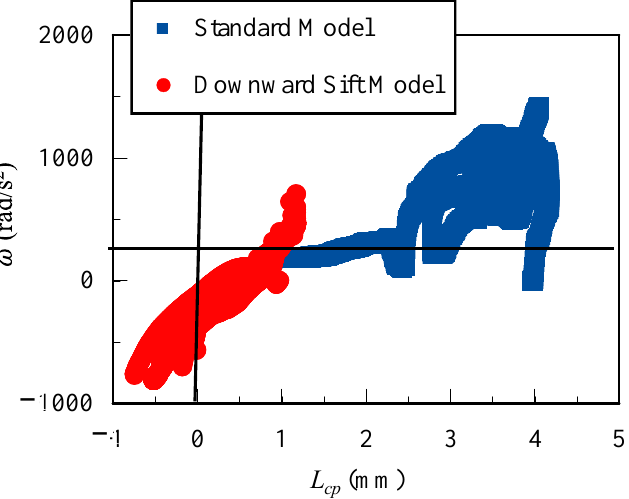
Figure 11. Relationship of distance between center of gravity of ball and center of inlet pipe and rotational angular acceleration.